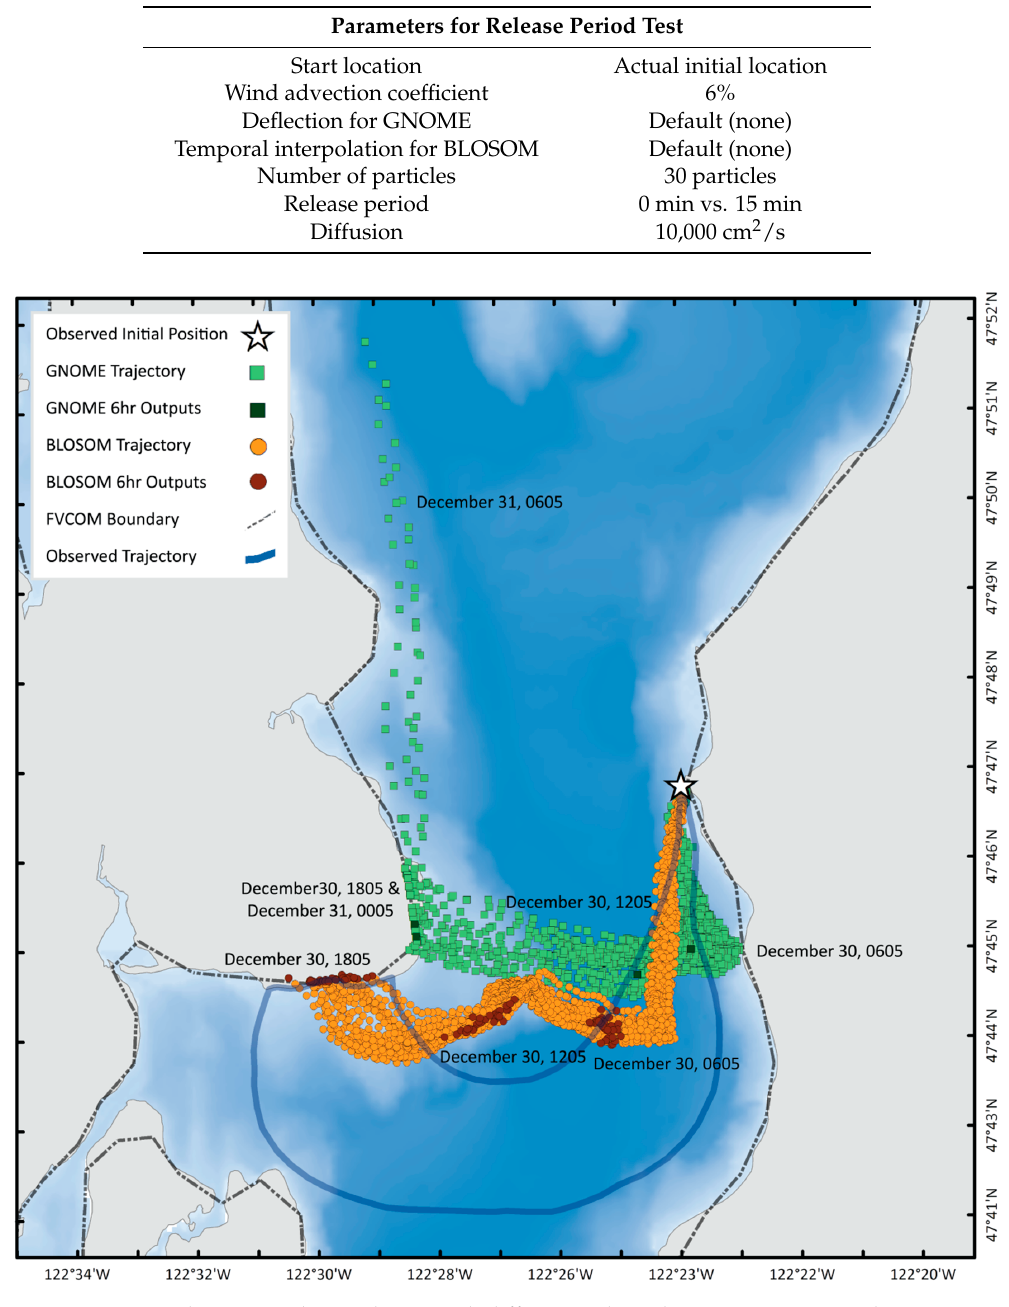
Figure 19. Thirty-particle simulation with diffusion, released over a 15 min period; test 8.